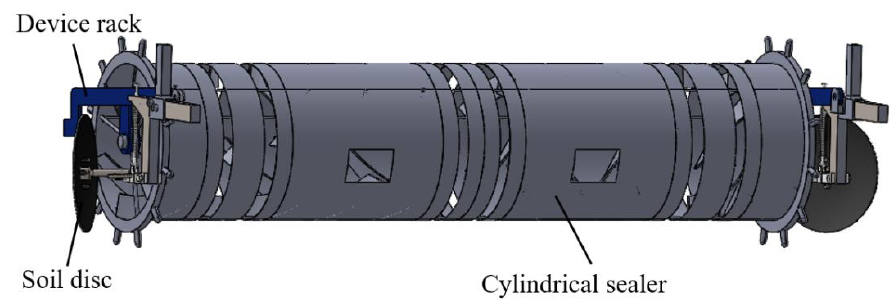
Figure 2. Device structure of soil mulching device.